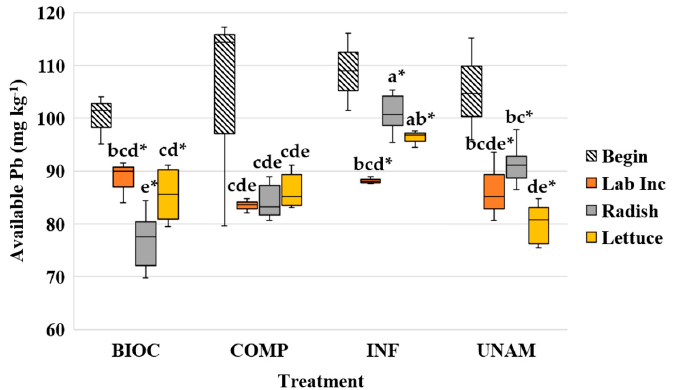
Figure 3. Available lead (Pb) concentrations in soils amended with biochar (BIOC), compost